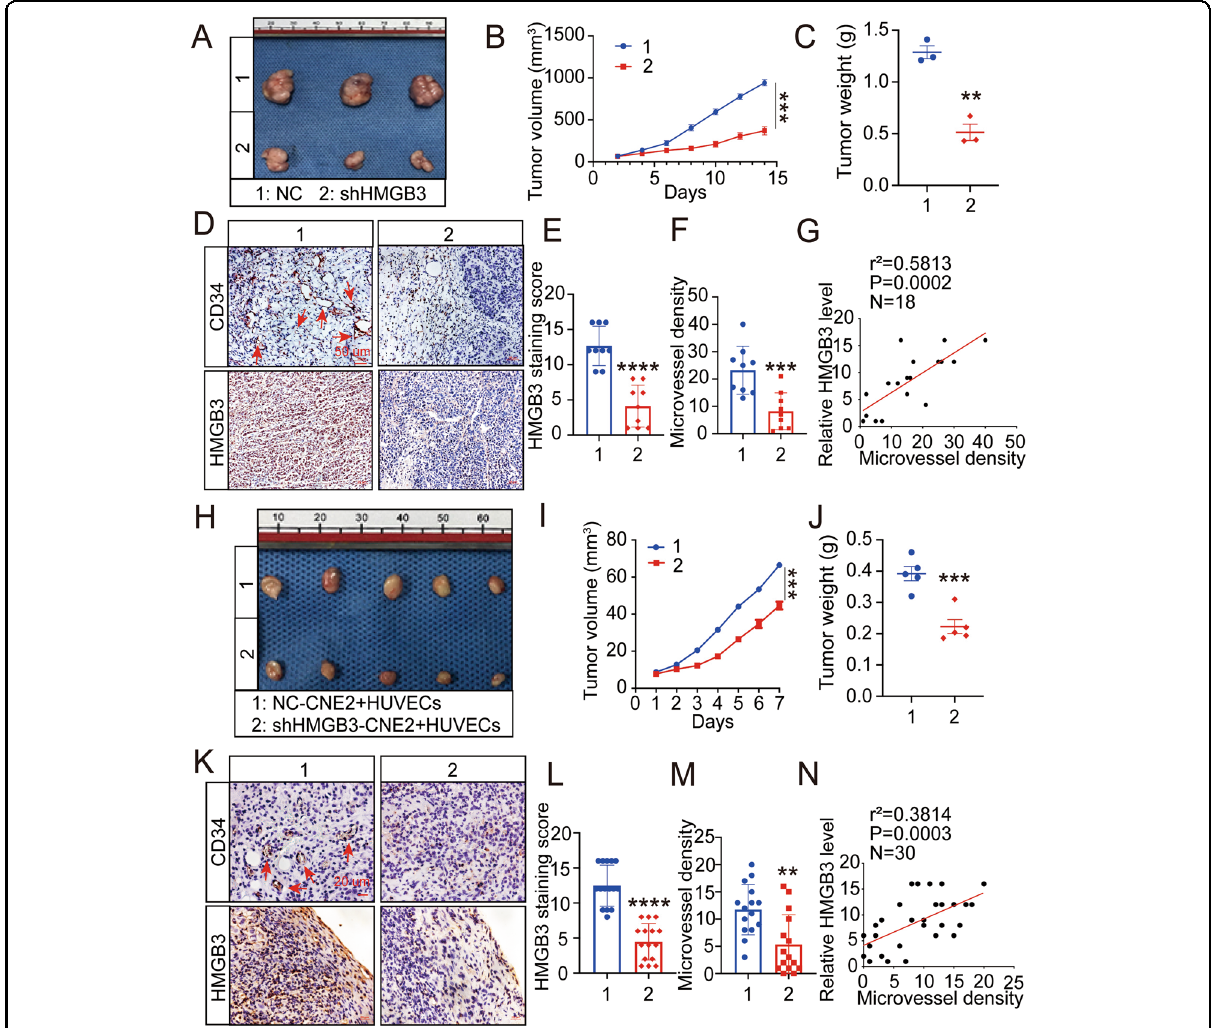
Fig. 4 Overexpression of HMGB3 correlates positively with MVD in NPC xenografts. A , H Images of corresponding tumour xenografts. B , I Tumour volume in the two groups. C , J The weights of the excised xenografts. D , K Representative images of IHC for CD34 and HMGB3 in tissues collected from two groups of NPC xenografts. E , L Quanti fi cation of IHC staining score for HMGB3 expression. F , M Statistics of microvessel density. G , N Spearman correlation between HMGB3 score and MVD in tumour xenografts. Pearson correlation coef fi cient ( r 2 ) and P value are shown. The scale bar in 400× images represents 50 µm. The red arrows indicate microvessels. Mean ± SD, ** P < 0.01, *** P < 0.001, **** P < 0.0001, student ’ s